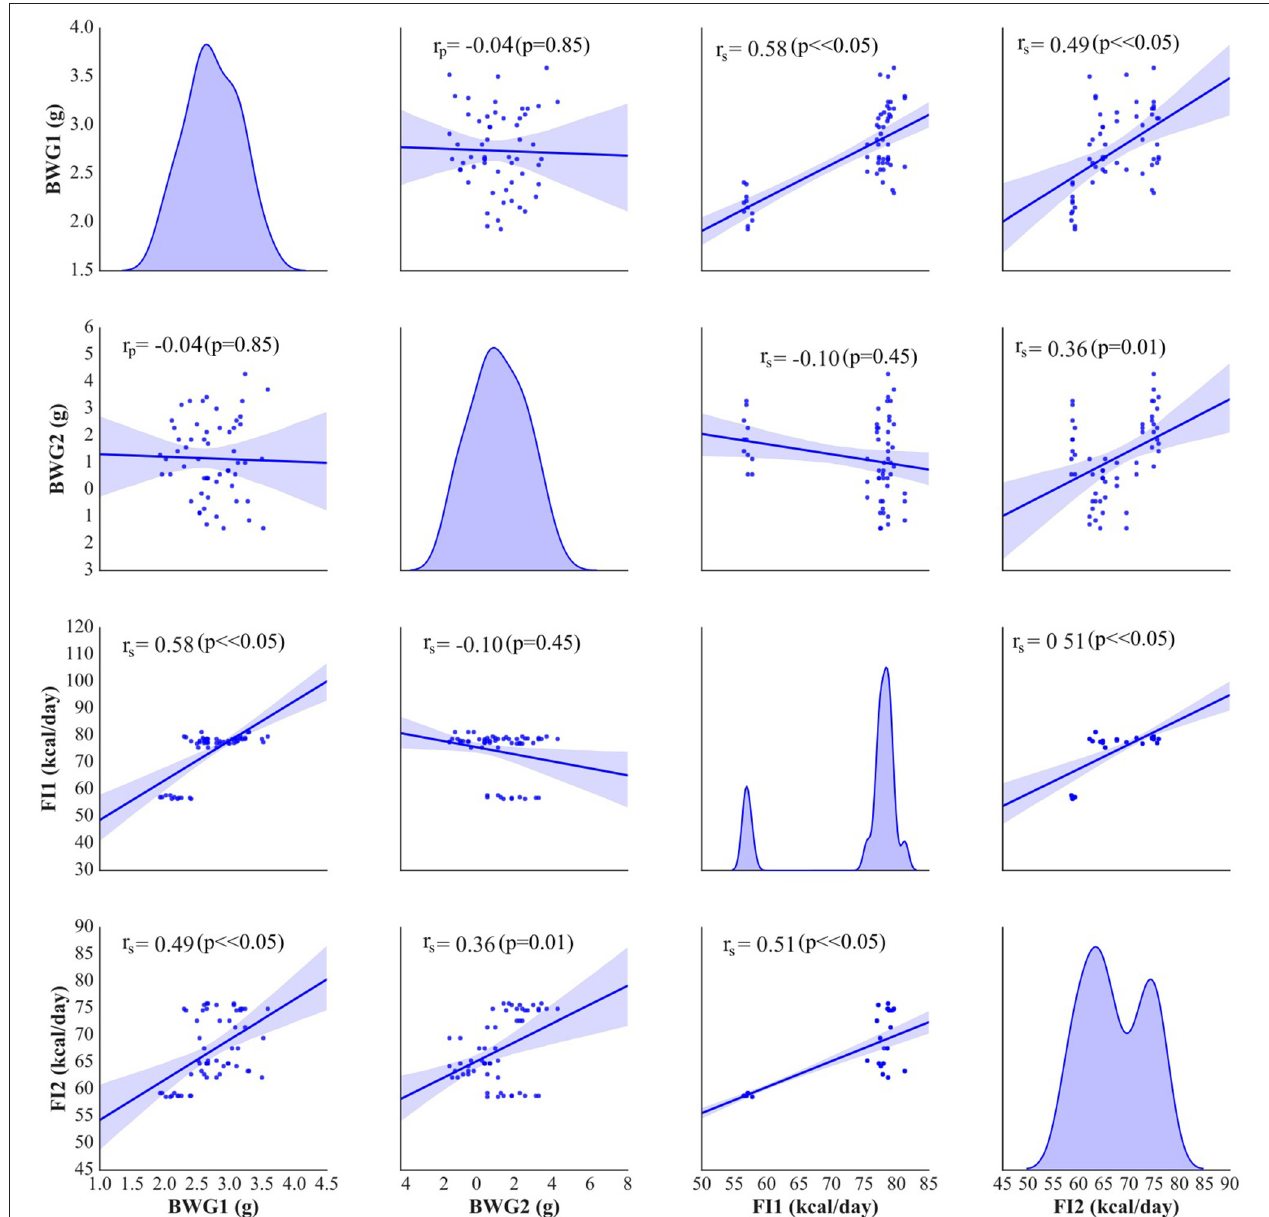
FIGURE 3 | Pearson’s or Spearman’s correlation between body weight gain (BWG1) [g/day] and the average food intake (FI1) [kcal/day] before stimulation and during tDCS application (BWG2 and FI2, respectively). On the diagonal of the multiple pairwise bivariate distribution plot, the kernel density estimate of the probability density function is shown for each variable subjected to the correlation